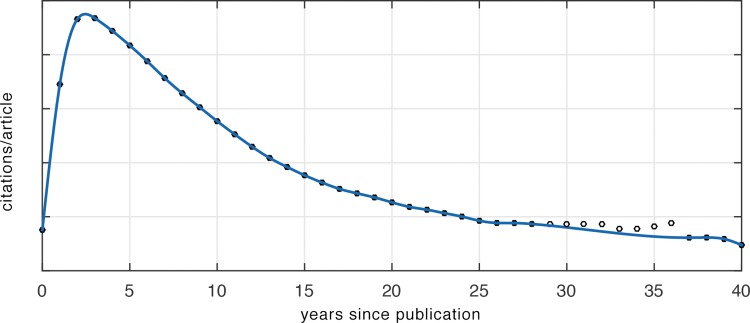
U-M citation curve, 1975–2013.